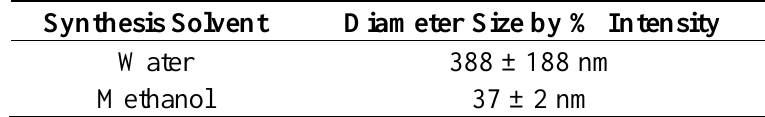
Table 2. Average agglomerate size of nanoparticles synthesized in water and methanol.